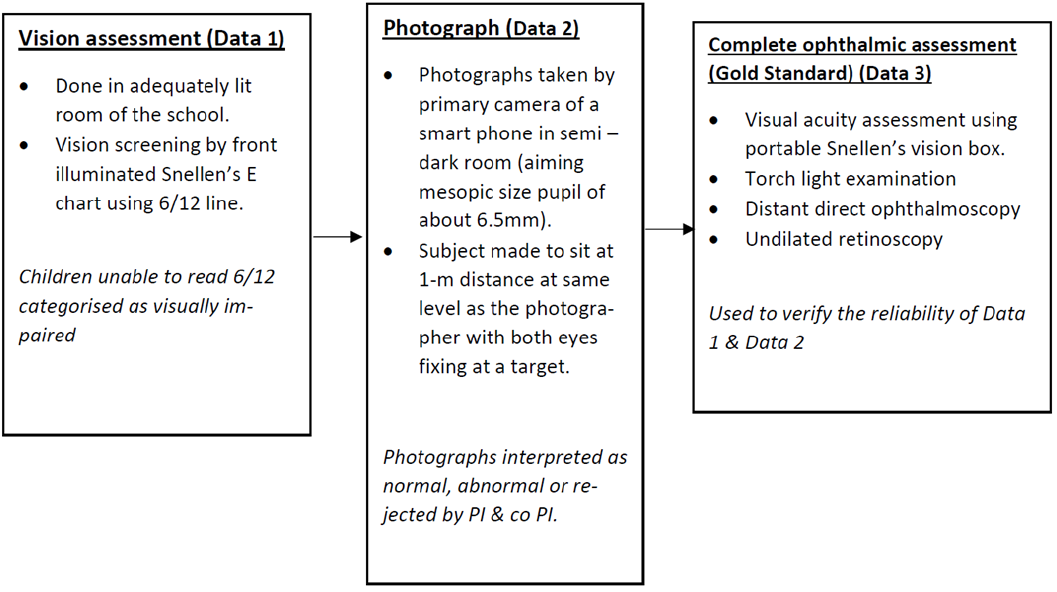
Figure 2. Flowchart depicting the scheme of events in the study. Datasets 1 & 2 were compared with dataset 3. Students randomly underwent visual acuity screening ( Data 1 ) or smartphone photography ( Data 2 ) as the first screening